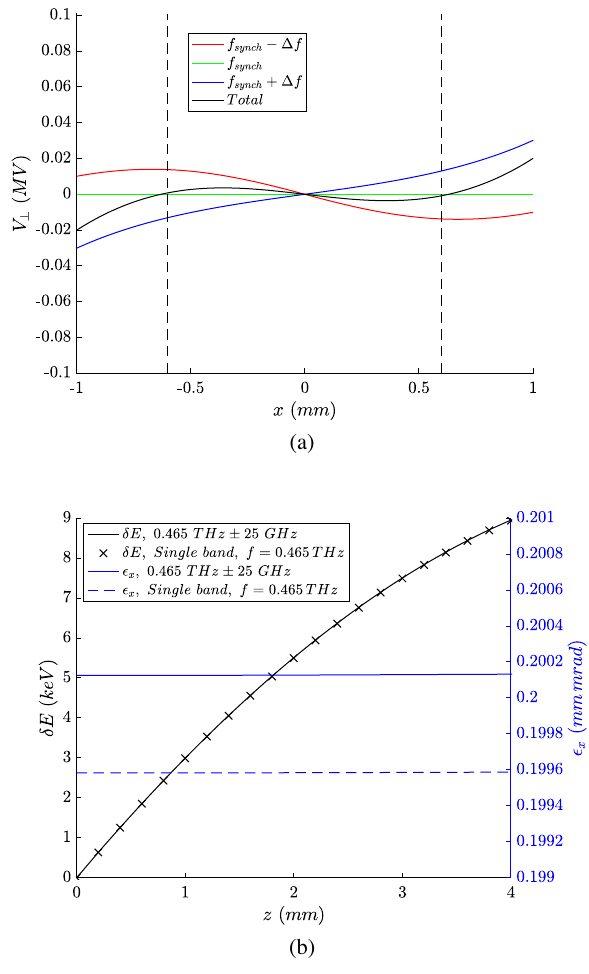
FIG. 16. (a) Transverse voltage regarding the longitudinal monopole component of the THz field for synchronous fre- quency, sidebands and their sum. (b) Effect of the total transverse voltage due to bandwidth on energy spread and emittance in a single structure. A beam with a geometric emittance of 0.2 mm mrad was tracked for both single frequency and broadband cases for an energy gain of 400